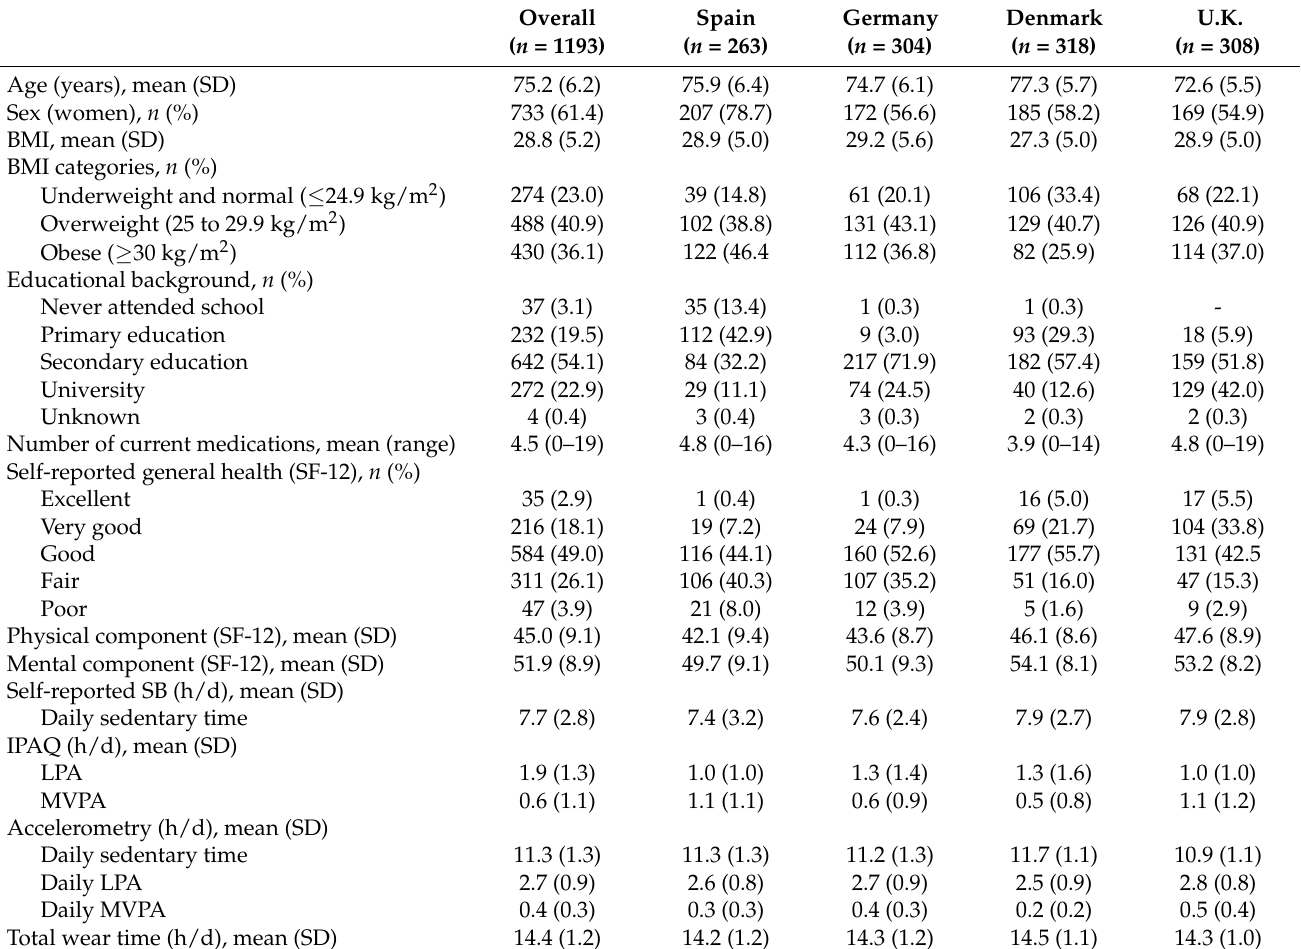
Table 1. Descriptive variables of the sample.